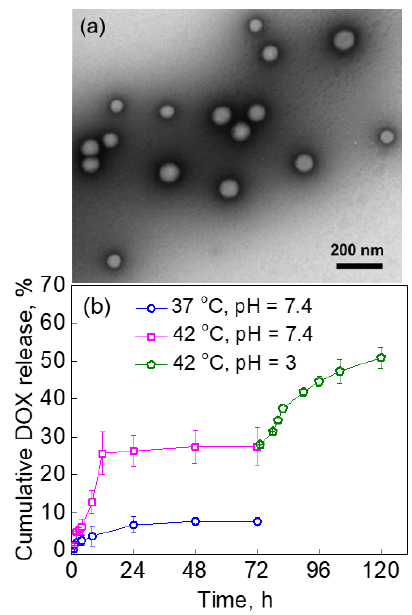
Figure 6. ( a ) TEM image of drug-encapsulated PVCL 5 -PDMS 30 -PVCL 5 polymersomes. The vesicles were loaded with DOX from 1 mg mL − 1 drug solution and had a loading capacity of 34%. ( b ) The time-dependent DOX release from DOX-loaded PVCL 5 -PDMS 30 -PVCL 5 polymersomes at varied temperatures and pH